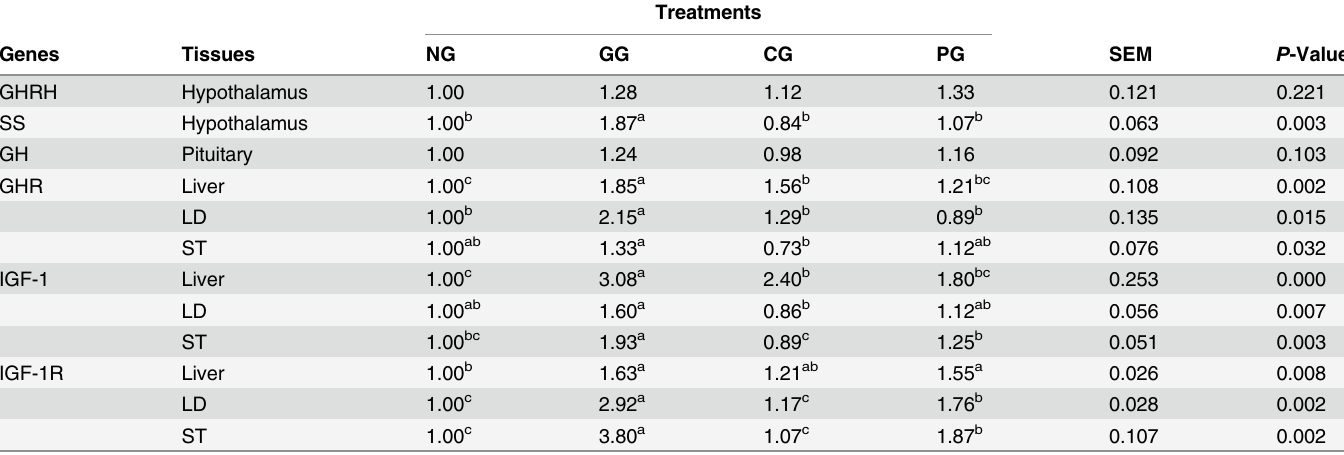
Table 5. The effects of GHRP-2 and CS on somatotropic axis hormone gene expression in yaks with growth retardation.